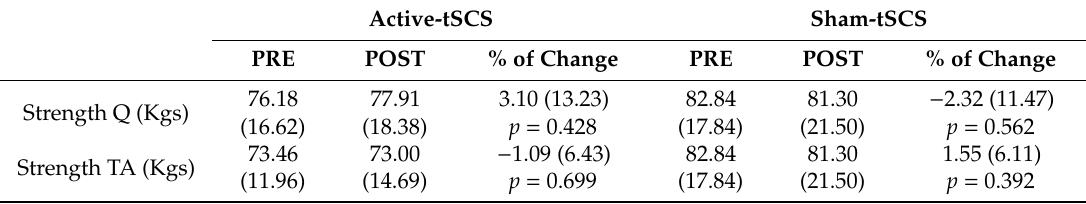
Table 3. Isometric maximal voluntary contraction strength following tSCS or Sham. Mean (SD).